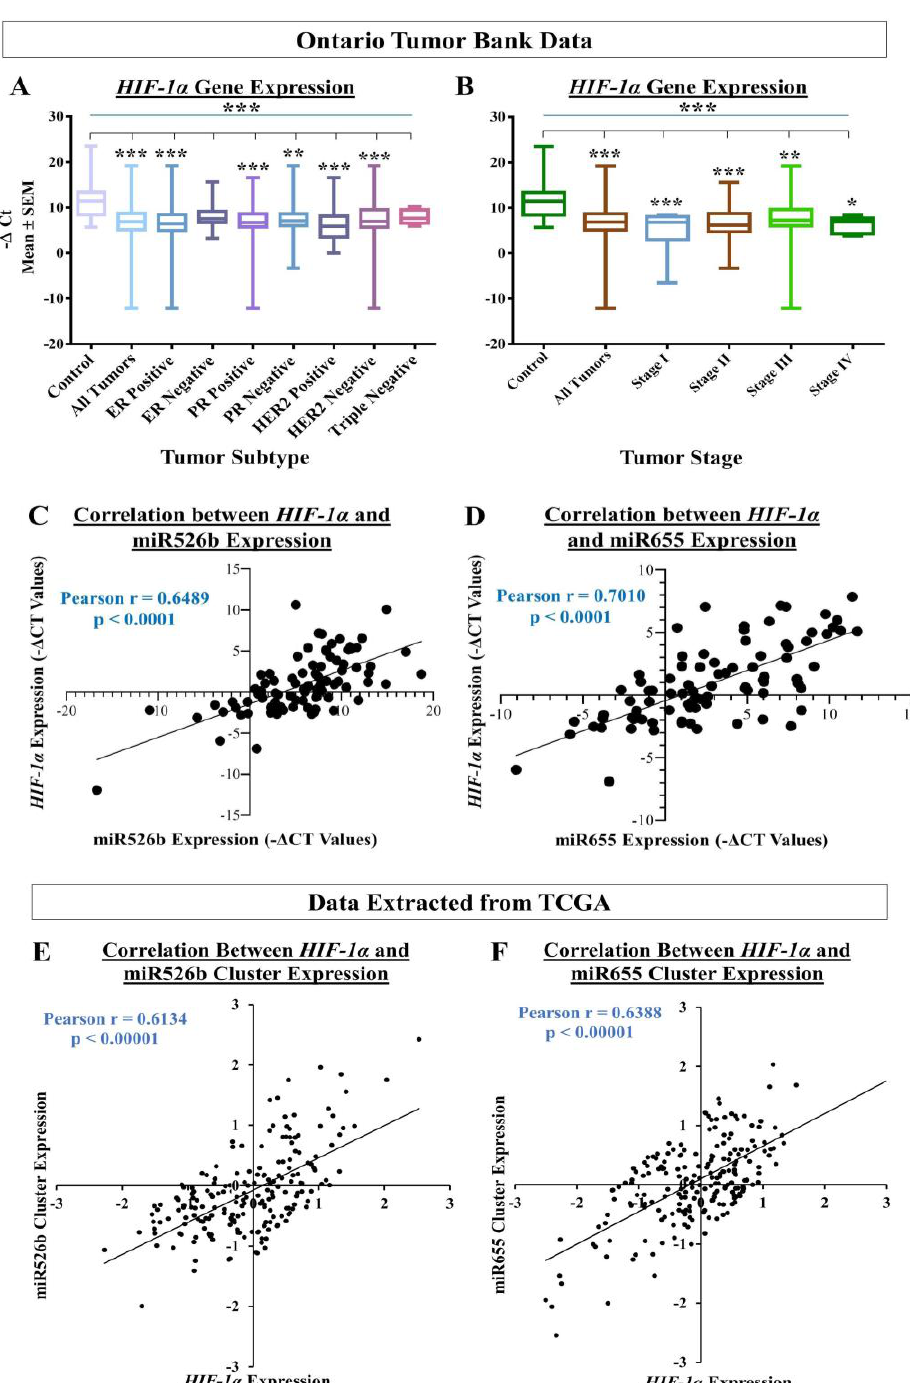
Figure 12. Human tumor and control tissue data: ( A ) Delta CT (∆CT) of HIF-1α expression in control tumor tissues, all tumor tissues, ER-positive/negative, PR-positive/negative, HER2-positive/negative, and triple-negative tumor samples. ( B ) HIF-1α expression in stage I, II, III, and IV tumors. ( C ) Correlation between HIF-1α and miR526b expression in tumor samples. ( D ) Correlation between HIF-1α and miR655 expression in tumor samples. In figures A and B, the Y -axis represents -∆CT, as smaller ∆CT values indicate higher expression. ( E ) Correlation between HIF-1α and miR526b cluster expression in tumor samples. ( F ) Correlation between HIF-1α and miR655 cluster expression in tumor samples. * p < 0.05, ** p < 0.01 and *** p < 0.001.